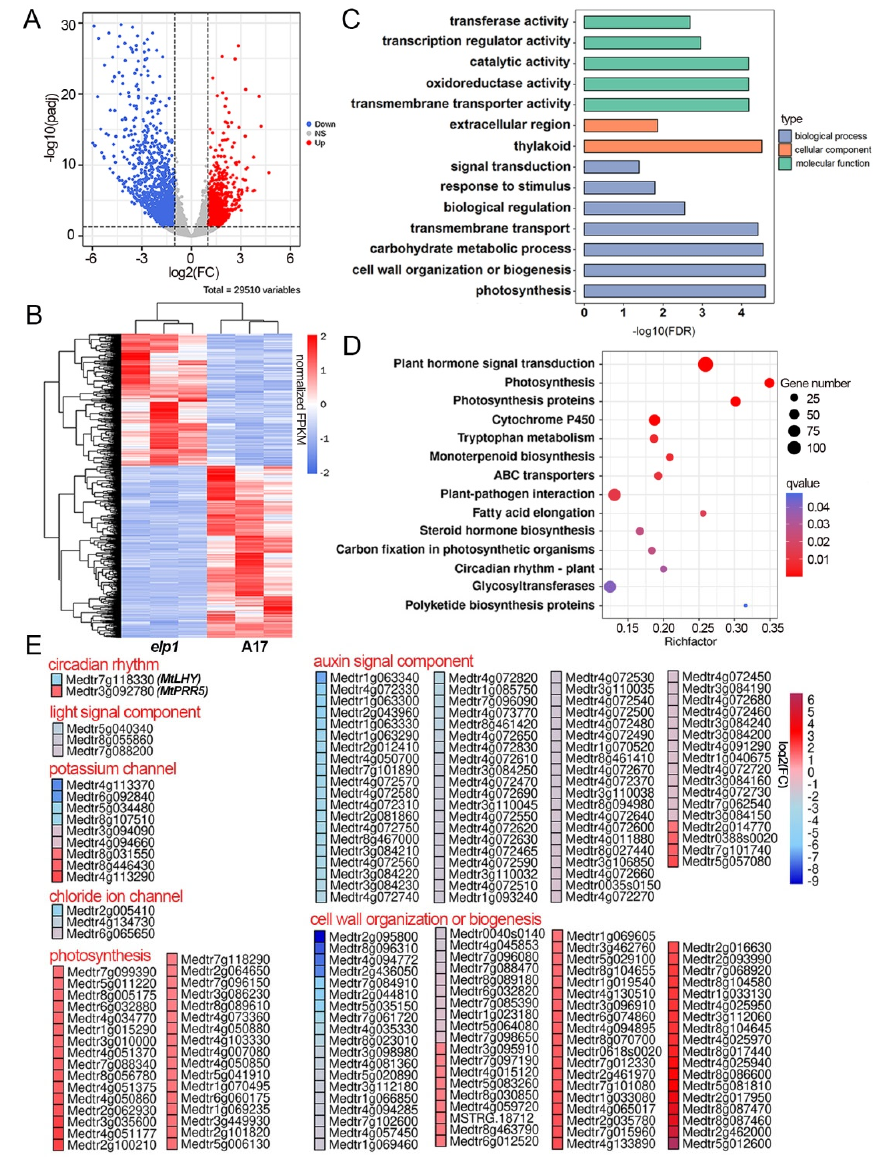
Figure 2. DEGs involved in pulvinus development and signal transduction were identified in elp1 mutant. ( A ) Volcano plots of differentially expressed genes between WT and elp1 mutants after RNA-seq analysis. Up-regulated and down-regulated genes are presented in red and blue color dots, respectively. The x-axis represents the natural logarithm of fold change (Fc) and the y-axis represents log 10 of the adjusted p -value of each transcript. The blue and red dots represent the downregulated and upregulated genes, respectively. ( B ) Hierarchical clustering analysis of all the differentially expressed genes (DEGs) in WT (A17) and elp1 mutant samples. ( C ) Gene ontology (GO) enrichment analysis of the DEGs between WT and elp1 mutants. ( D ) Pathway enrichment of differentially expressed genes. The upregulated DEGs are enriched above blue dotted line, while downregulated DEGs are enriched below the blue dotted line. ( E ) Selected significantly differentially expressed genes in potassium channel, chloride ion channel, circadian rhythm, light signal component, cell wall organization or biogenesis and auxin signal